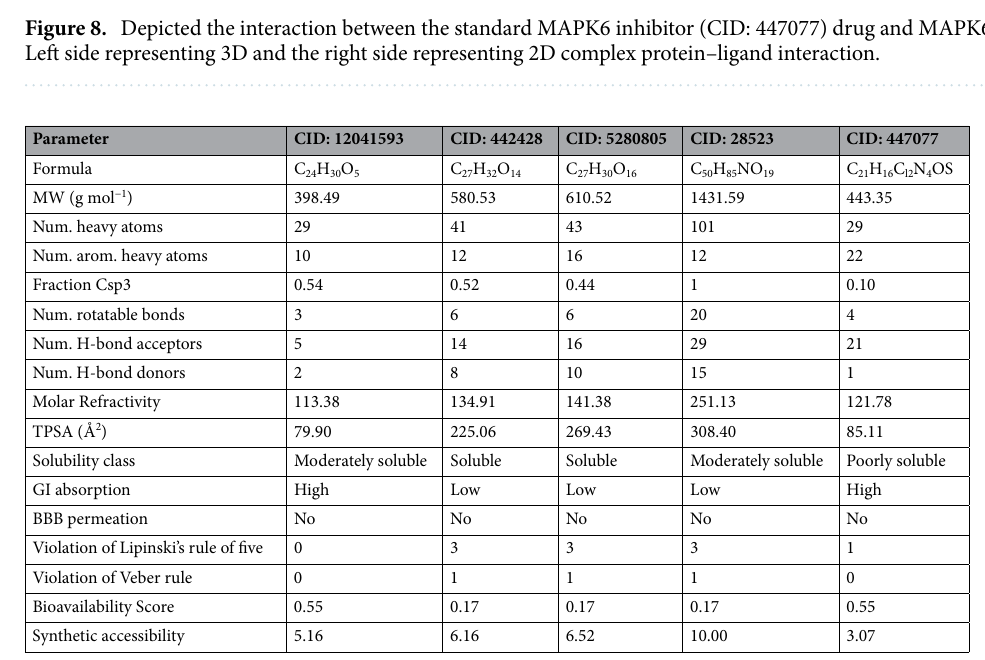
Table 5. Pharmacokinetics and physicochemical parameters of selected bioactive compounds and standard MAPK6